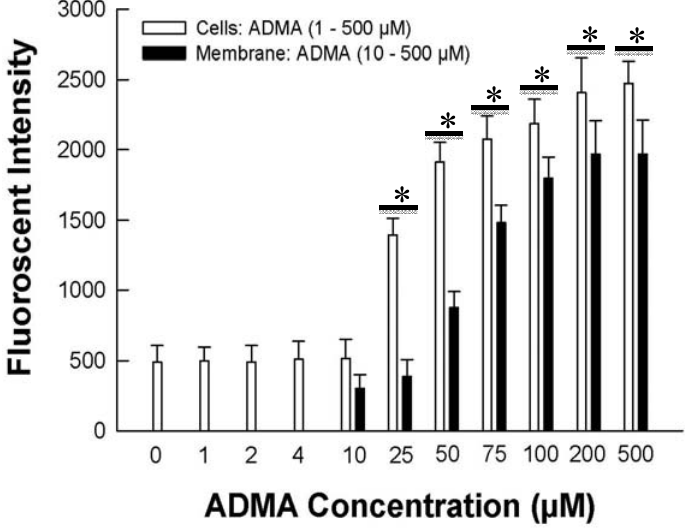
Figure 1. Dihydroethidium (DHE) fluorescence in human umbilical vein endothelial cells (HUVEC) whole cells incubated chronically for 7 days with 0 to 500 µM asymmetric dimethylarginine (ADMA), or HUVEC membranes incubated for 30 min with 10 to 500 µM ADMA. * p < 0.05 versus 10 µM ADMA whole cell or cell membrane treatment. n =